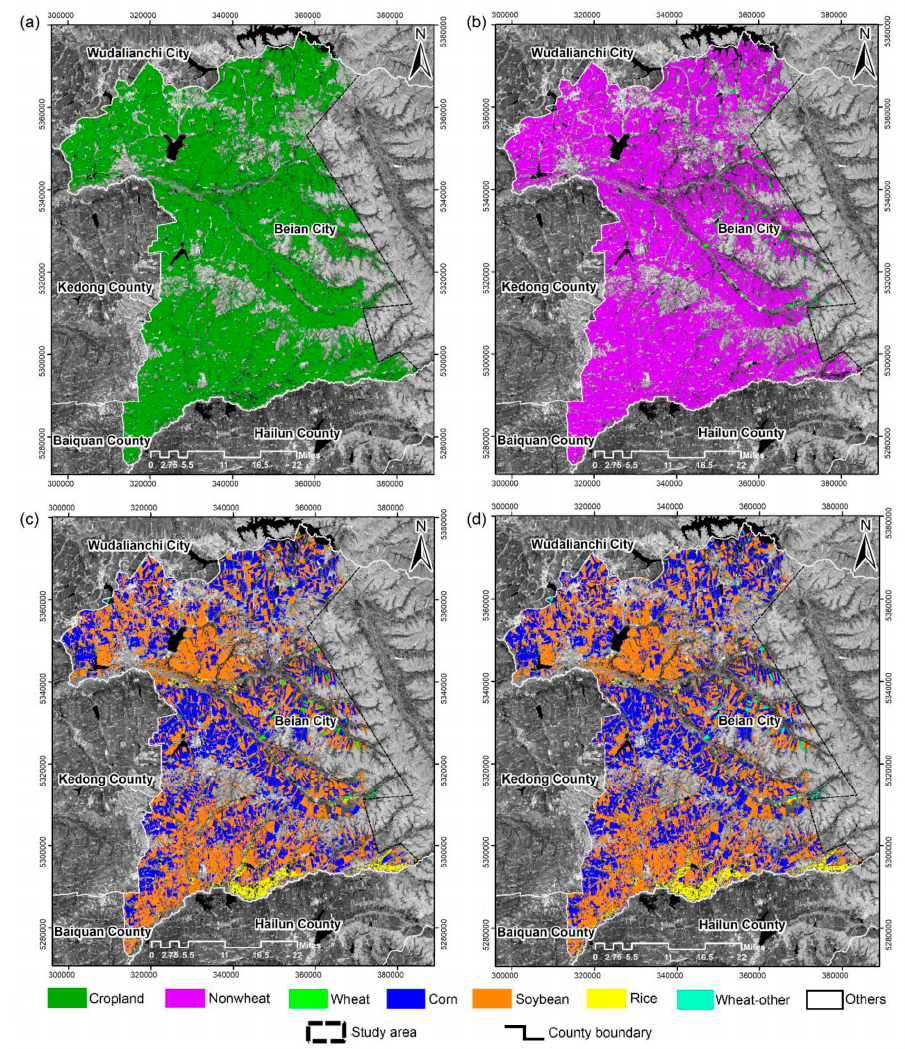
Figure 8. In-season crop maps derived from RF at TST feature subspace. ( a ) ES; ( b ) SP; ( c ) SM; ( d ) AT. ES in the early spring season; SP in the spring season; SM in the summer season; AT in the autumn season.